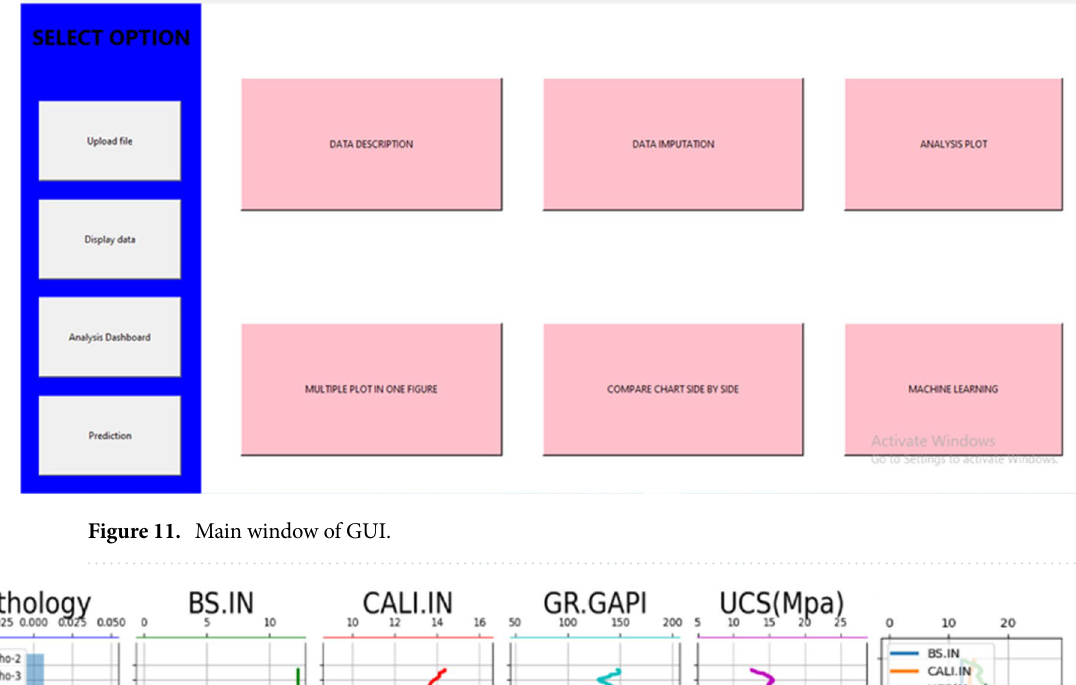
Figure 11. Main window of GUI.